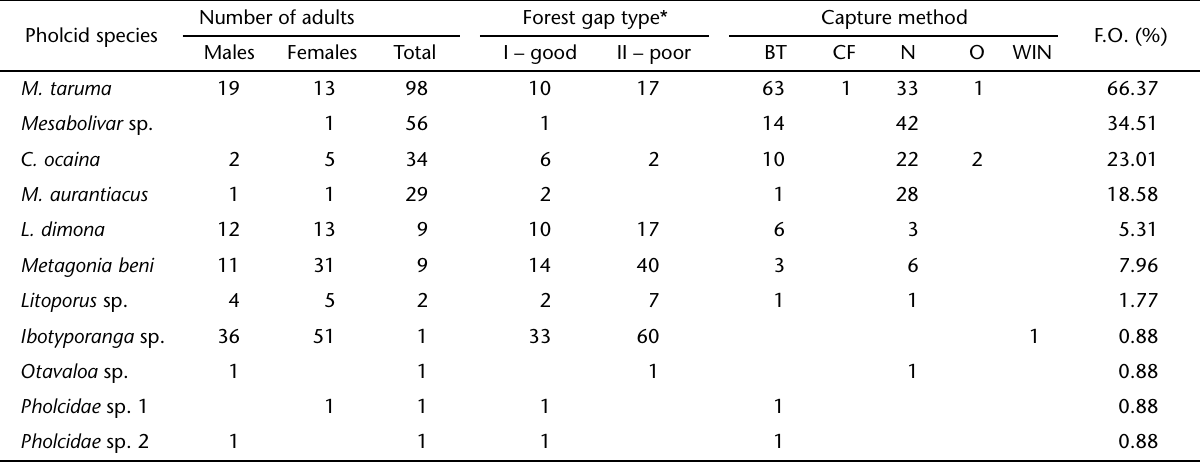
Table I. Summary of the abundance and capture method of the Pholcidae species found at Porto Urucu, Coari, Amazonas, Brazil. (BT) Beating tray, (N) nocturnal hand collecting, (WIN) Winkler extractor, (CF) canopy fogging, (O) occasional sampling, (FO) frequency of occurrence. *”Forest gap type” does not certainly represent the number of individuals collected in the whole basin. Pholcid